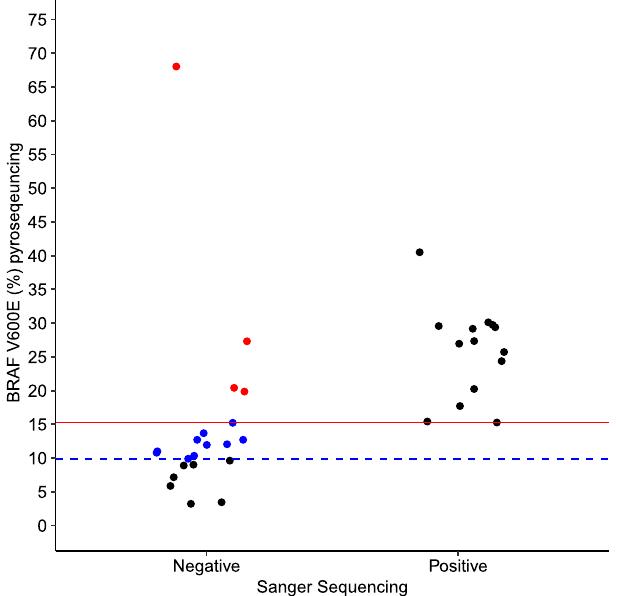
Figure 1. Limits of detection of BRAF V600E allele for pyrosequencing and Sanger ( n = 35). The red line represents the observed limits of detection of BRAF mutated allele by Sanger (> 15%). The doted blue line represents the threshold (> 9.82%) used to define a sample as positive for BRAF V600E mutation by pyrosequencing. Pyrosequencing detected BRAF V600E mutation in 10 samples (blue dots) that were negative by Sanger. Four samples were positive by pyrosequencing (red dots) but were negative by Sanger, even if the percentage of mutant allele was greater than